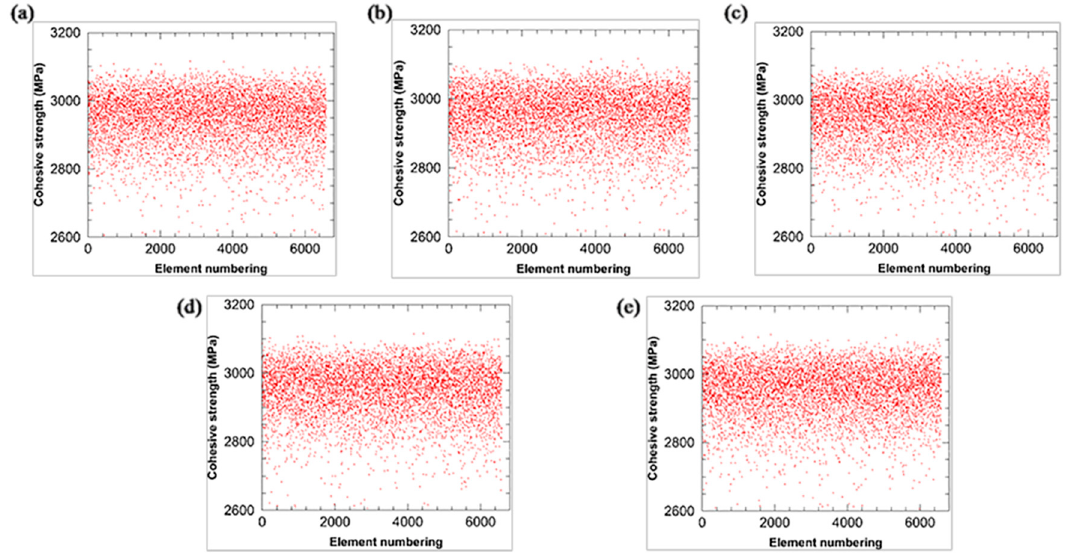
Figure 7. Weibull random fields: ( a ) No. 1, ( b ) No. 2, ( c ) No. 3, ( d ) No. 4, and ( e ) No. 5.